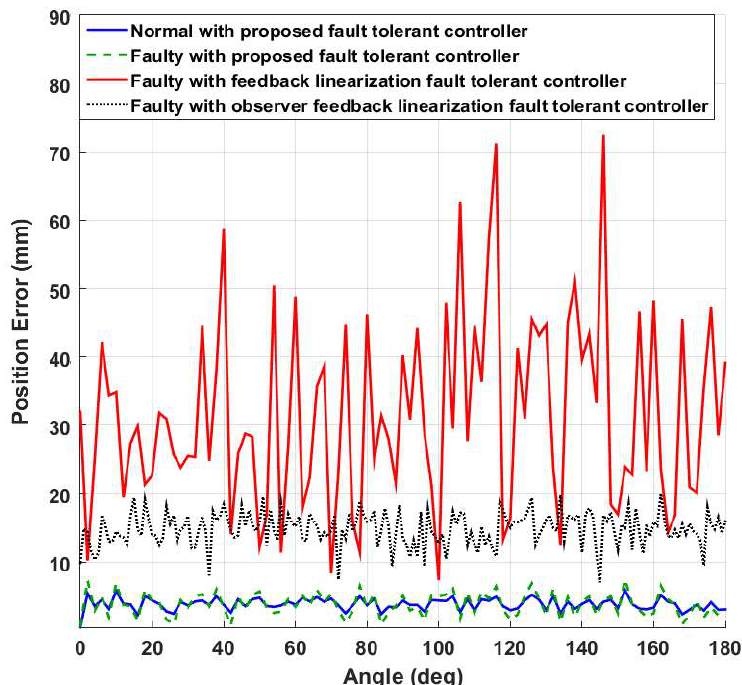
Figure 24. Position error for normal condition, faulty condition with the proposed fault-tolerant controller, faulty condition with the feedback linearization fault-tolerant controller, and faulty condition with the observer feedback linearization fault-tolerant controller.